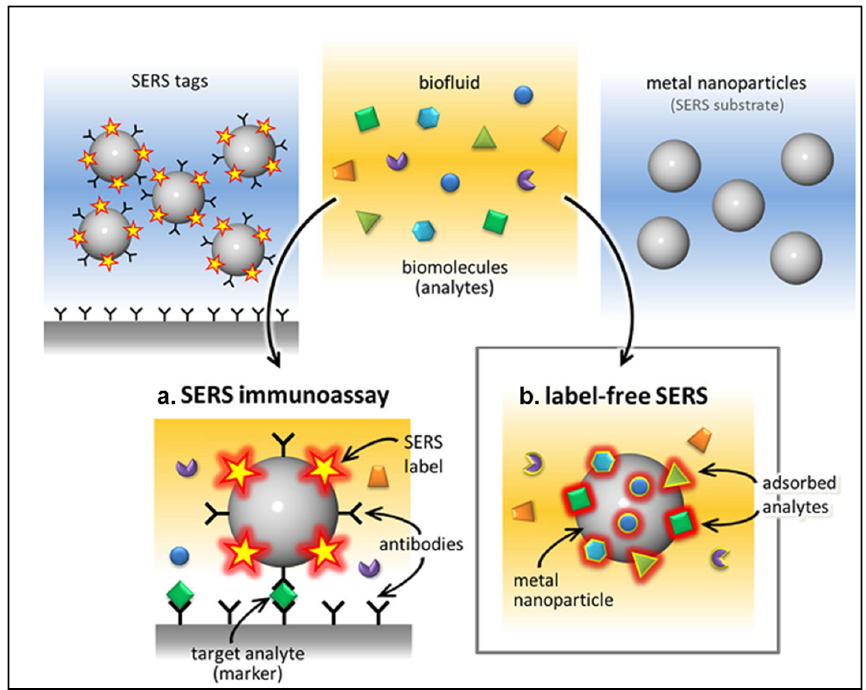
Figure 1. Surface-enhanced Raman scattering (SERS) approaches: a. label-based (extrinsic) and b. label-free (intrinsic) SERS. Reproduced with permission from Bonifacio et al. [54]. Copyright © 2015, Springer Nature .